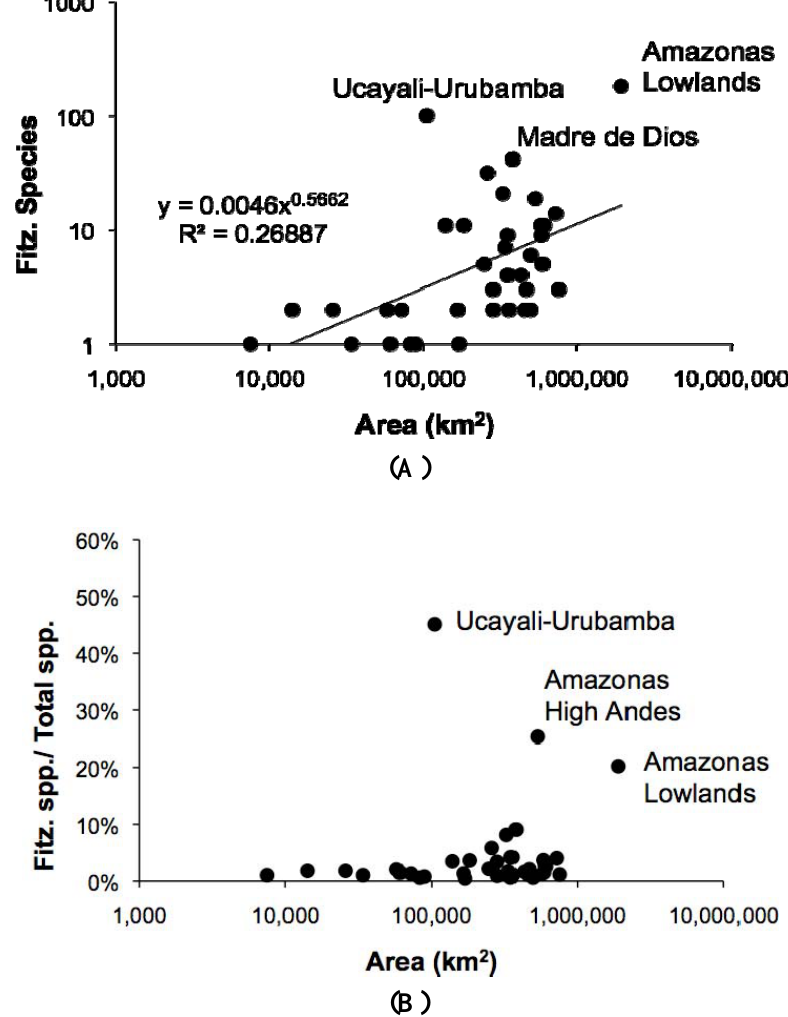
Figure 10. Species-area relationships for Fitzcarrald fish species (FFS) among the freshwater ecoregions of tropical South America. Species richness and area data from [5]. (A) Absolute numbers of FFS per ecoregion, showing high shared species composition with faunas in the adjacent Amazonas Lowlands, Ucayali-Urubamba, and Madre de Dios ecoregions. (B) Proportional representation of FSS per ecoregion, showing relatively high values in some nearby ecoregions, and low values in most other